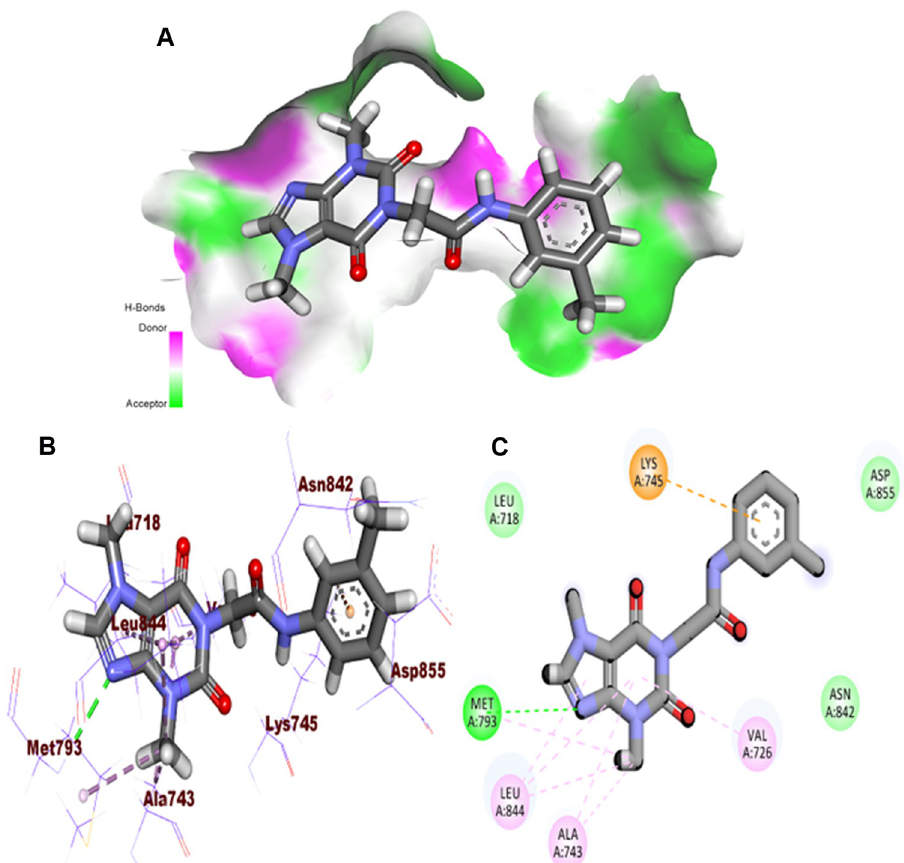
Fig 7. A: MS, B: 3D, and C: 2D close view of T-1-MTA with EGFR T790M .